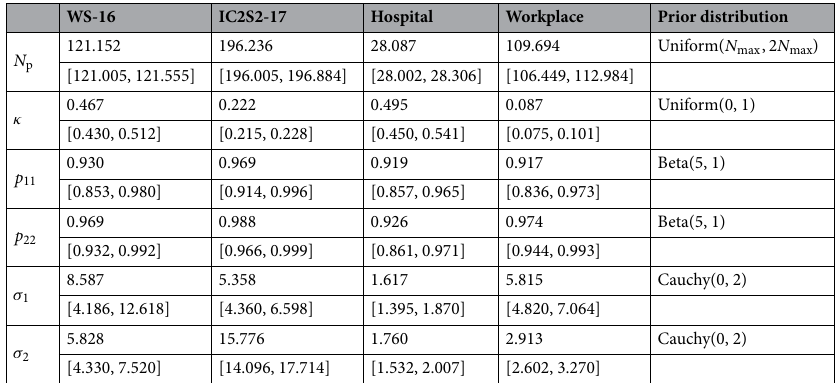
Table 1. Estimated parameters. For each parameter, mean and 95% credible interval obtained by MCMC are shown at the upper and lower rows, respectively. N max denotes max t { N t }